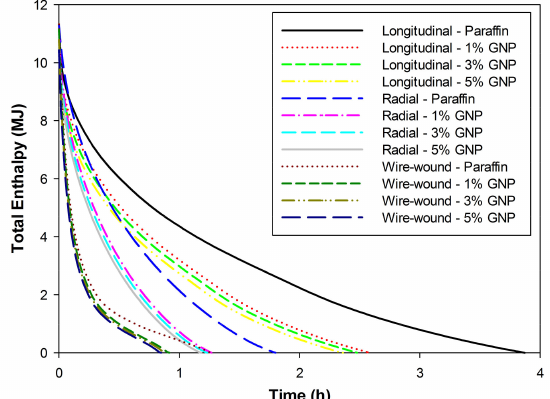
Figure 9. Total enthalpy discharged for paraffin and nano-PCMs in shell-and-tube with longitudinal, radial and wire-wound fins